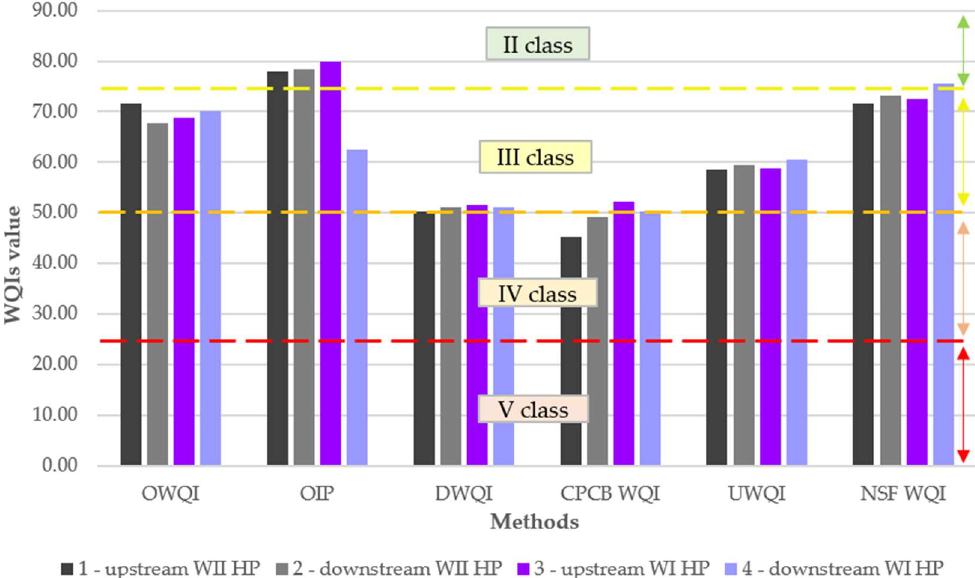
Figure 4. Results of water quality indices at the tested points within Wrocław I (WI) and Wrocław II (WII) hydropower plants on the Odra River (Poland).